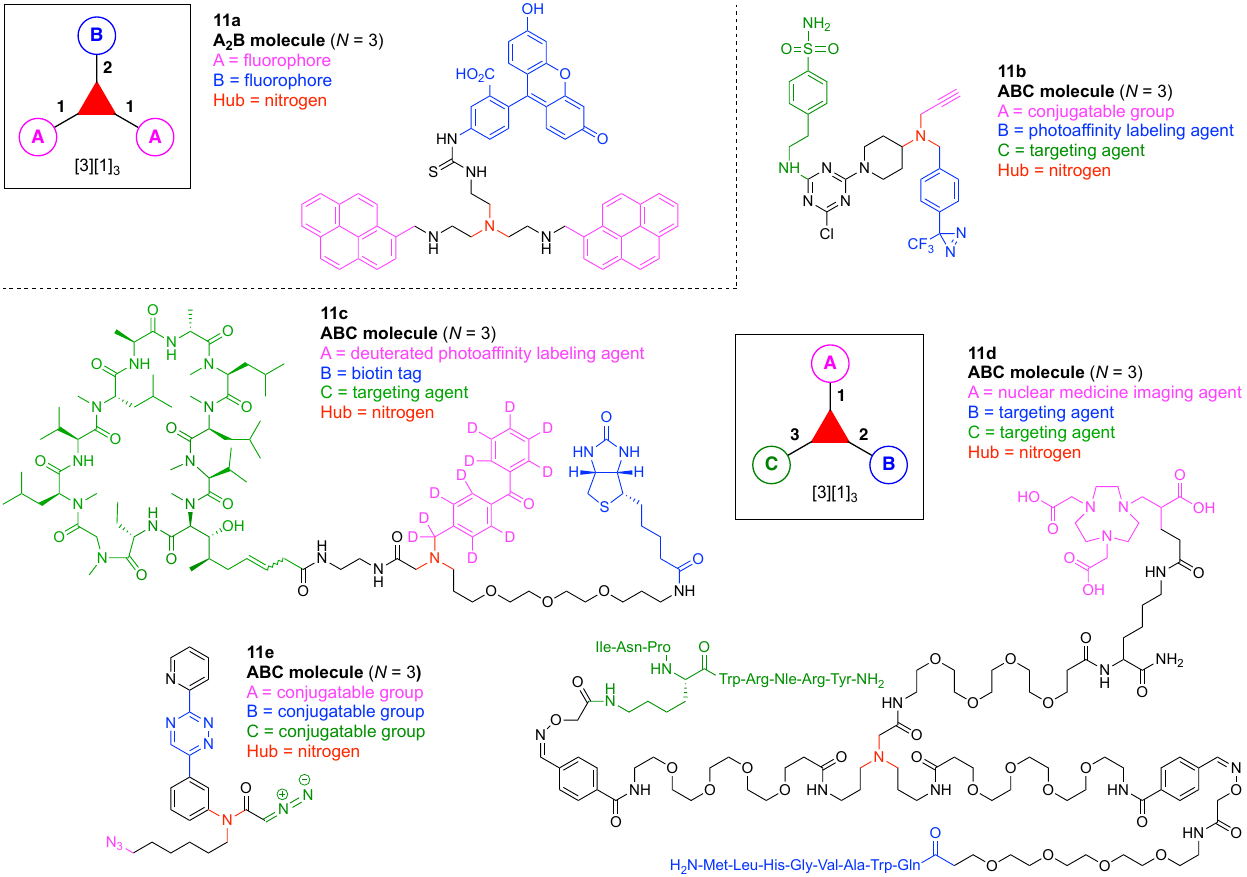
Figure 53. Examples wherein each contains a single nitrogen hub.